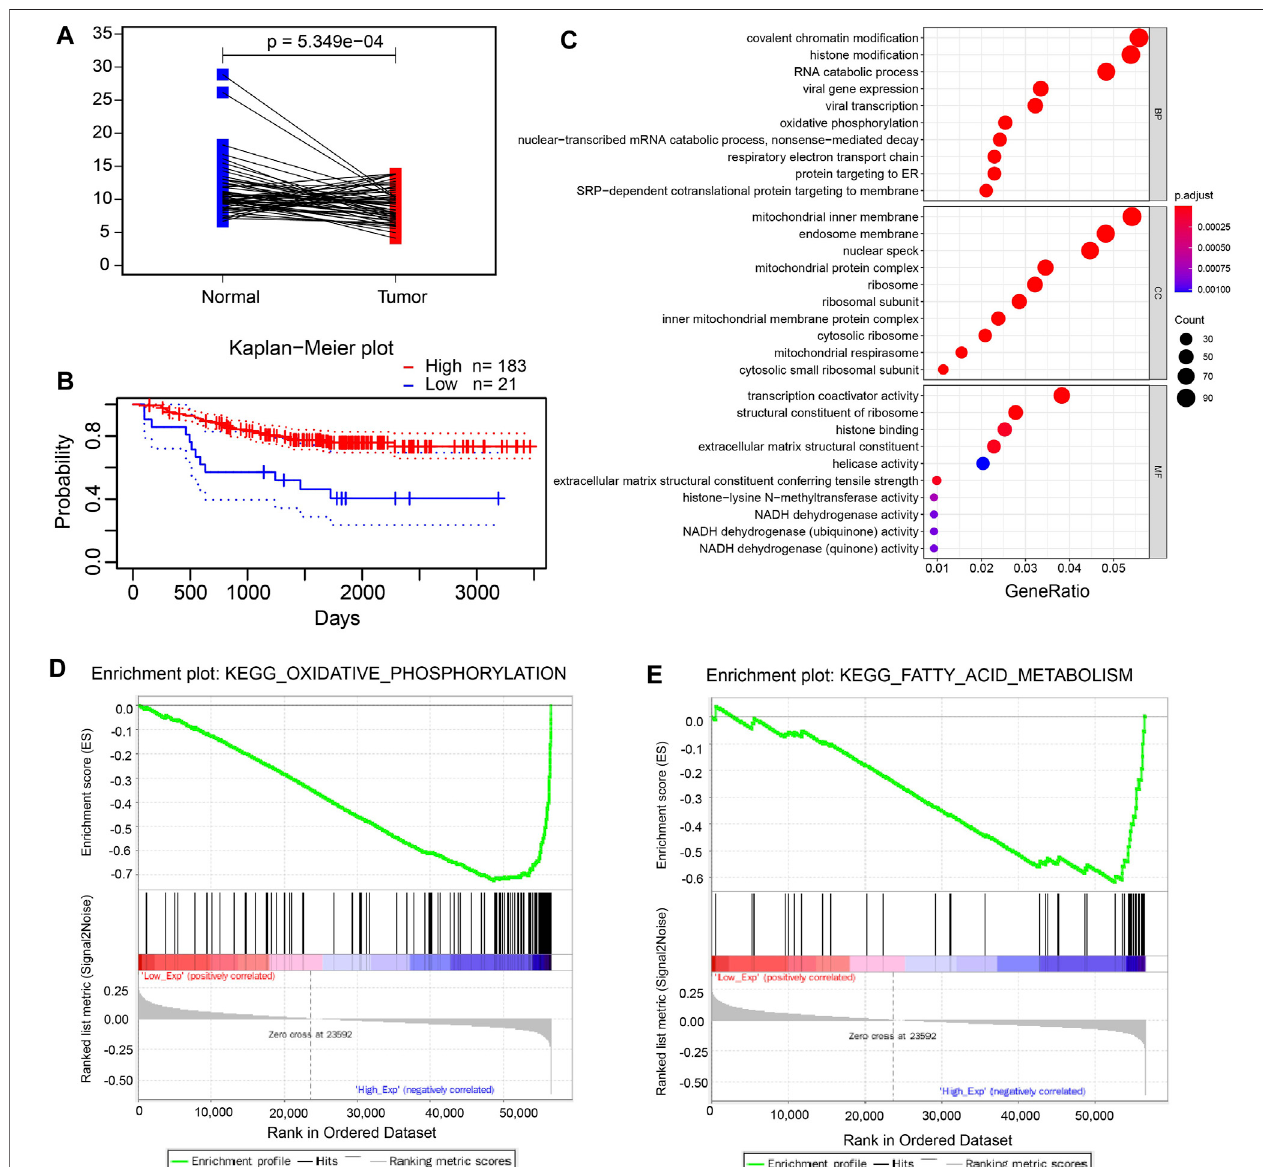
FIGURE4| FDX1playsapivotalroleinLUAD. (A) .ThemRNAlevelofpairedLUADtumortissuesandadjacentnormaltissuesintheTCGA-LUADdataset. (B) .The Kaplan – Meier plot of low expression and high expression of FDX1 in LUAD patients using the ProgScan online tool. c. The GO enrichment analysis of FDX1. (D, E) . The GSEA analysis of low expression of